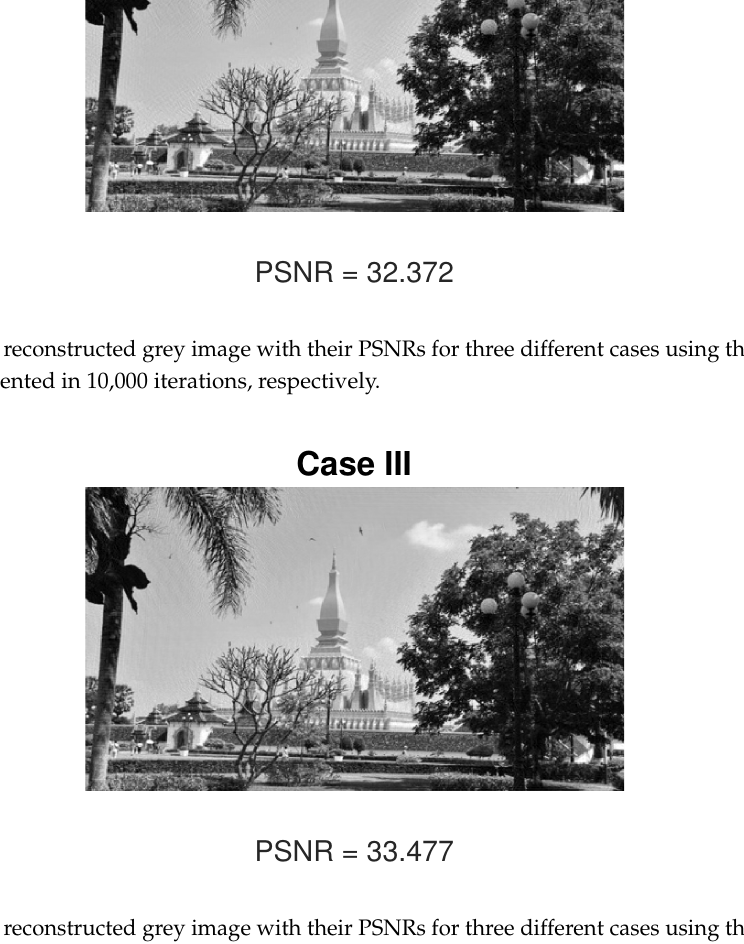
Figure 24. The reconstructed grey image with their PSNRs for three different cases using the proposed algorithm presented in 10,000 iterations,